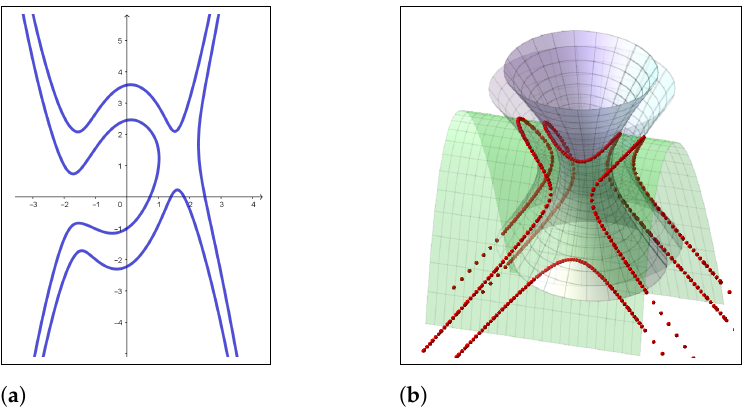
Figure 2. ( a ) Intersection curve. ( b ) Intersection of the offset with the